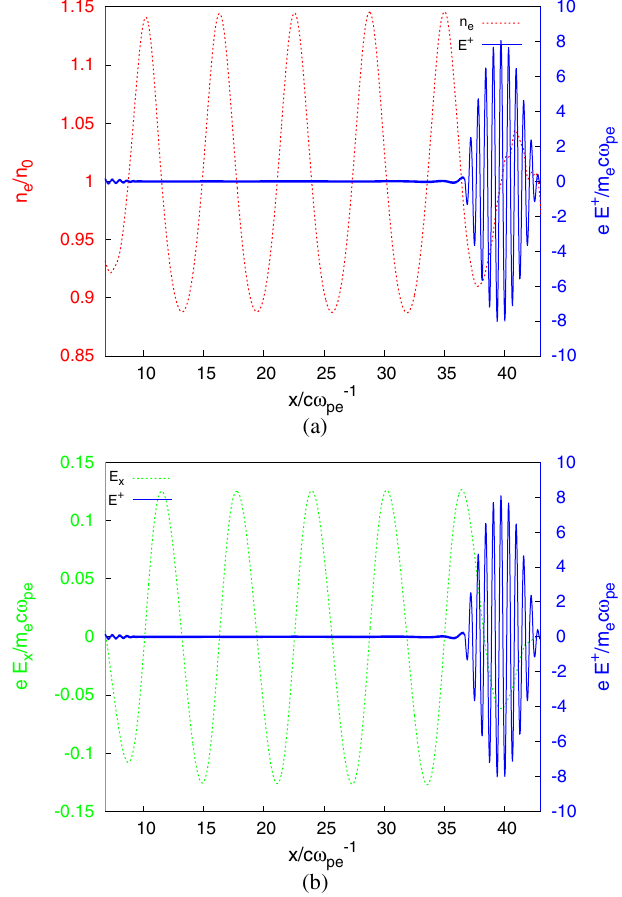
FIG. 1. (a) Electron density fluctuations n e (red dot line) and subsequently (b) electrostatic wakefields E x (green dot line) which are induced in plasma during the propagation of RCP laser pulse (which its electric field E þ is displayed by solid blue line) in a nonmagnetized underdense plasma slab. Figures are plotted ≃ 42 after the start of at t= ω − 1 pe E a ω 0 ¼ 0 0 is the amplitude of laser pulse. Only in the <t<L þ L interval − L < ξ < 0 and L þ L þ vacuum jump vacuum L , E 0 in nonzero. Wavelength of the laser is equal to jump λ 1 μ m and a 0 . 4 is normalized amplitude of laser 0 ¼ 0 ¼ vector potential, which corresponds to a laser intensity with I 0 ¼ 4 . 3 × 10 17 W = cm 2 .